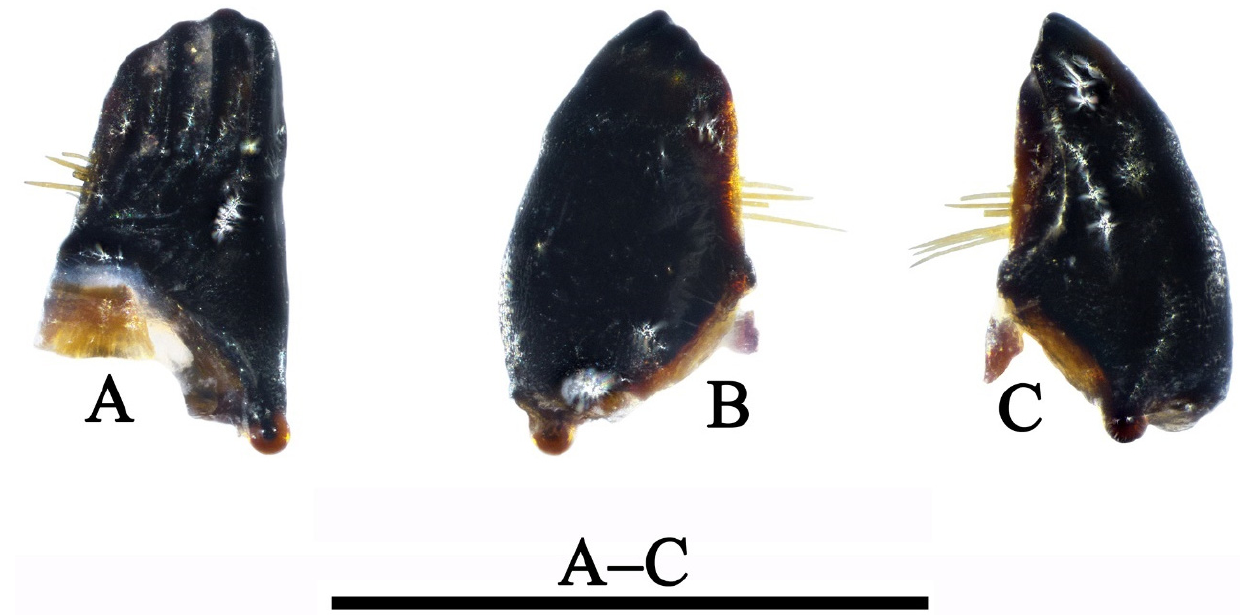
Figure 8. Limnephilus deqianensis n. sp. , larva left mandible. ( A ) Mesal; ( B ), dorsal; ( C ) ventral. Scale bar: 1 mm.